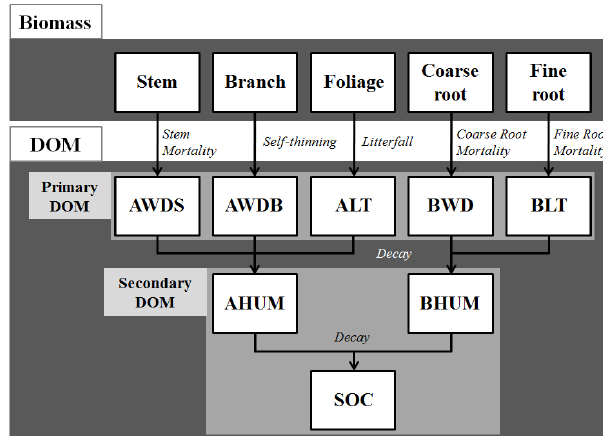
Figure 1. The schematic diagram of the modified forest soil dynam- ics model (KFSC) used in this study. The carbon pools consist of biomass compartments (stem, branch, foliage, coarse root, and fine root), primary dead organic matter (DOM) compartments (above- ground woody debris from stem (AWDS), aboveground woody de- bris from branch (AWDB), aboveground litter (ALT), belowground woody debris (BWD), and belowground litter (BLT)), and sec- ondary DOM compartments (aboveground humus (AHUM), be- lowground humus (BHUM), and soil organic carbon (SOC)). The carbon flows are shown as solid arrows. In Yi et al. (2013), the AWDS and AWDB, as well as the AHUM and BHUM were united as aboveground woody debris (AWD) and humus (HUM), respec-